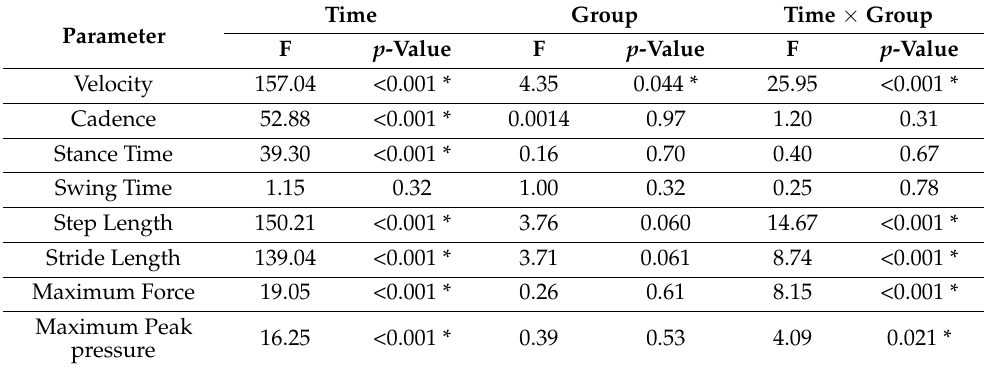
Table 2. Results from ANOVA applied to linear mixed models.